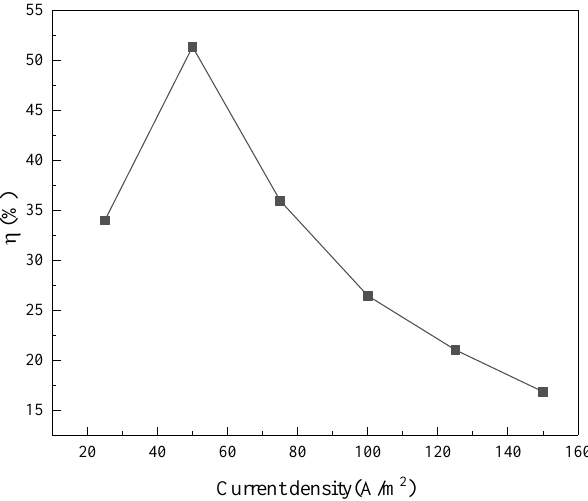
Figure 2. Desalination degree as a function of current density in the soy sauce desalination experiments.